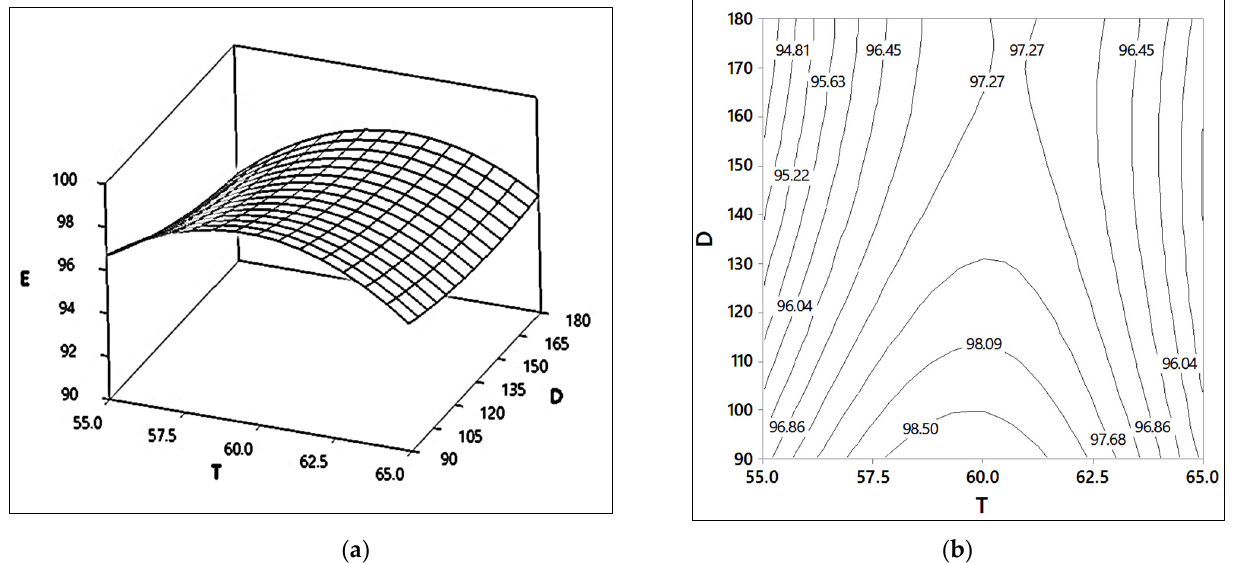
Figure 1. Interaction effect of temperature and time on the acidity removal of the WCO esterification process. ( a ) A 3D response surface plot of E (%) vs. T (°C) and D (minutes). ( b ) A 2D contour plot between D (minutes) and T (°C).